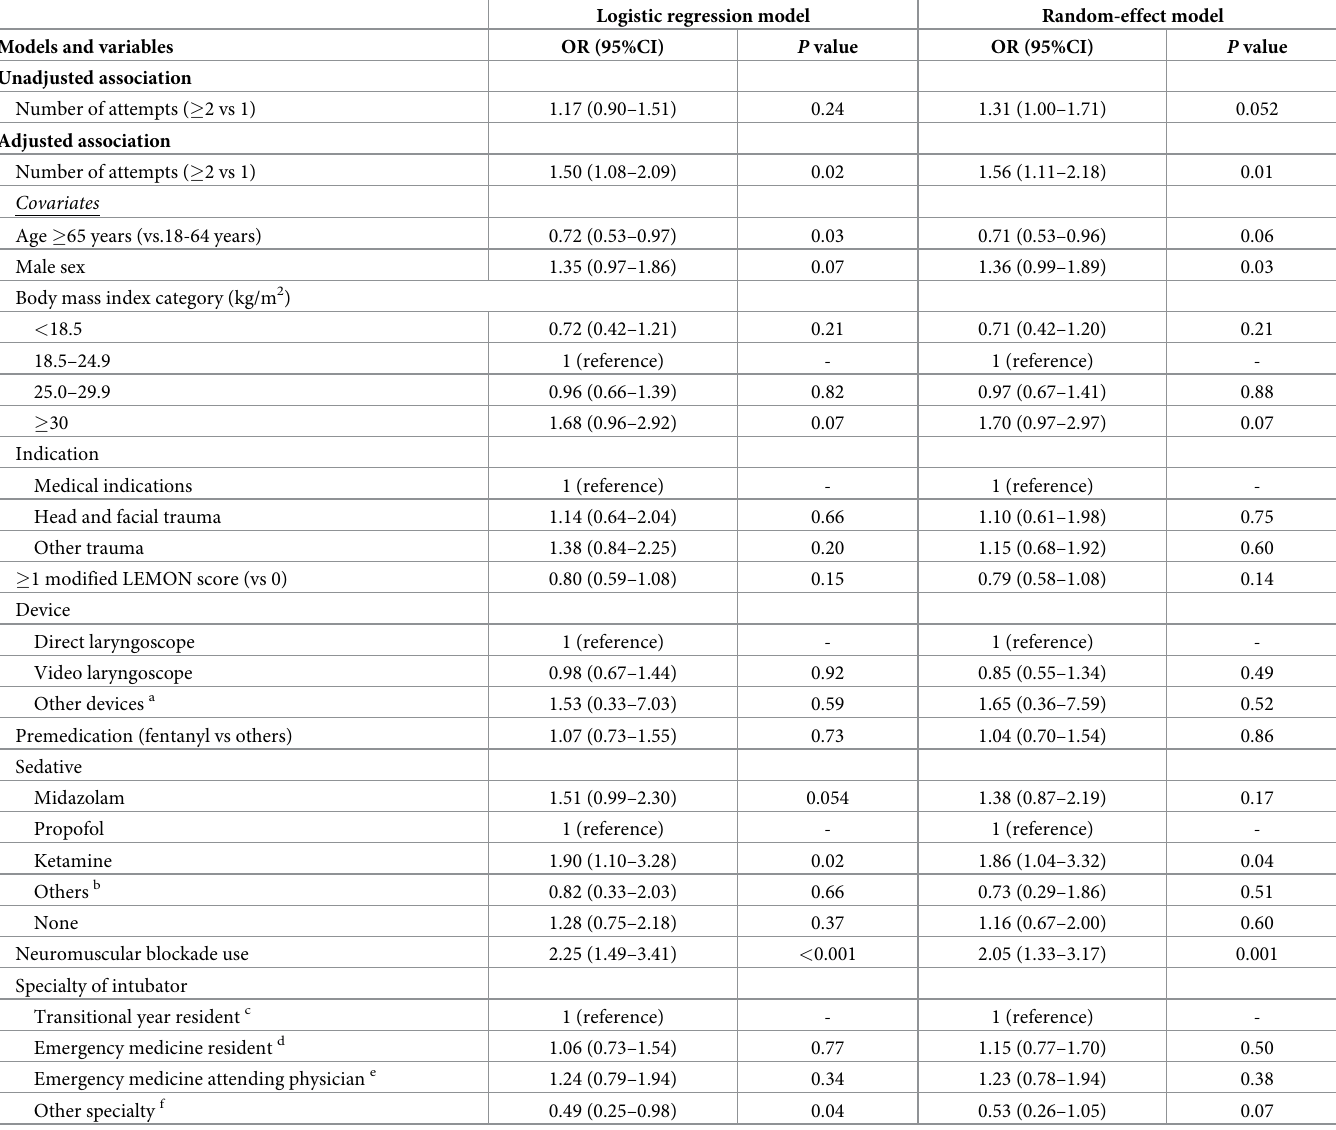
Table 3. Unadjusted and adjusted associations between the number of intubation attempts (primary exposure) and risk of post-intubation hypertension